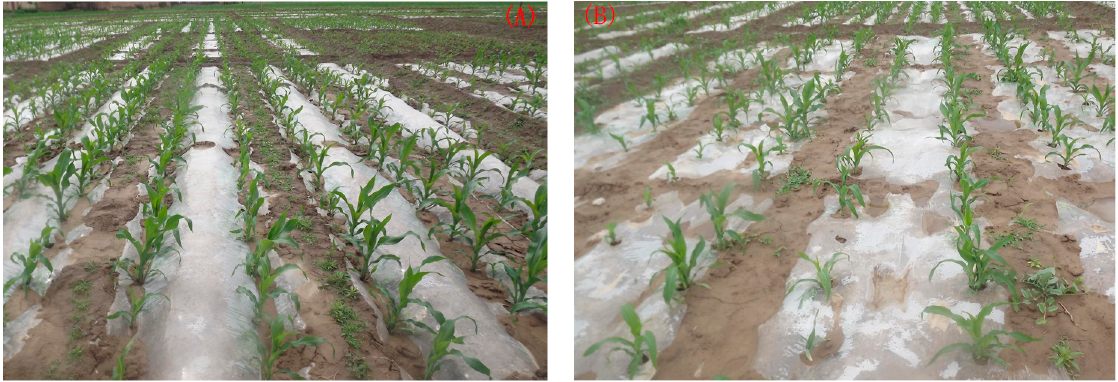
Figure 3. Experimental ( A ) ridge–furrow plastic film mulching and ( B ) flat planting with plastic film mulching.